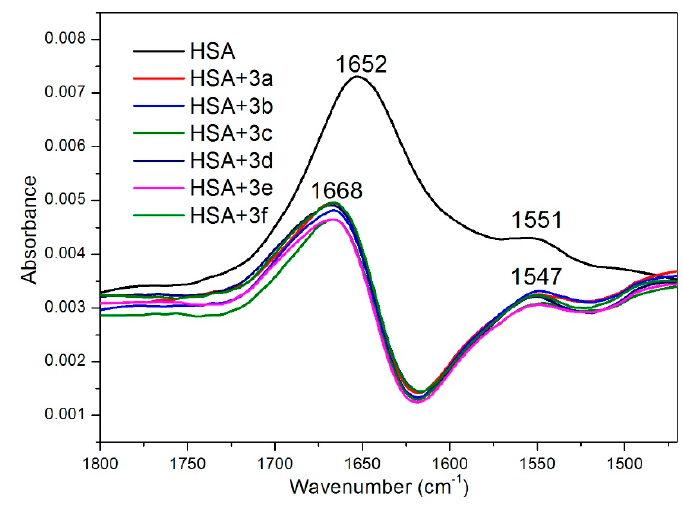
Figure 6 . FTIR spectra of free HSA (1.0 × 10 − 5 M) and the PDQL-HSA complex ((PDQL) = 2.0 × 10 − 5 M).